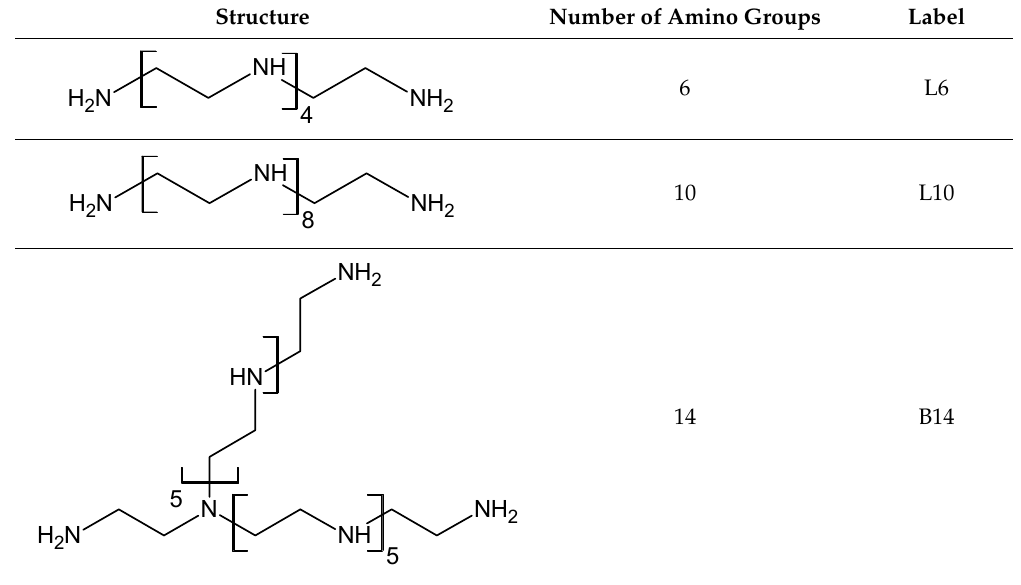
Table 1. Structures, number of amino groups (n) and labels of the di ff erent amines.